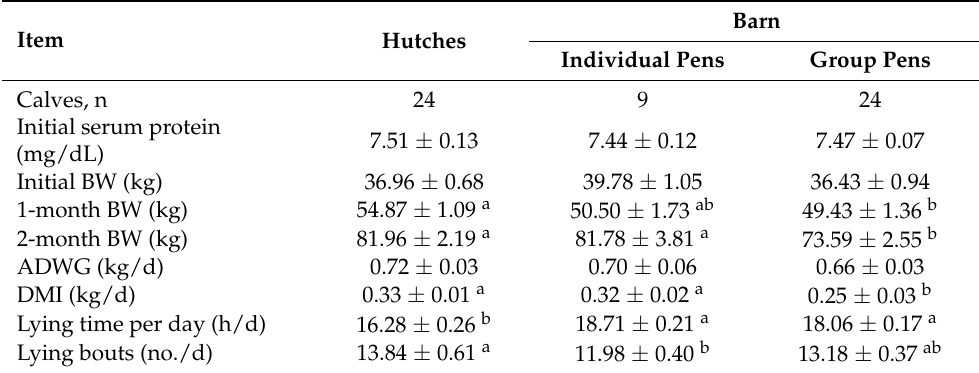
Table 3. Performance of calves housed in the hutches, individual pens, or group pens in the barn in the trial.